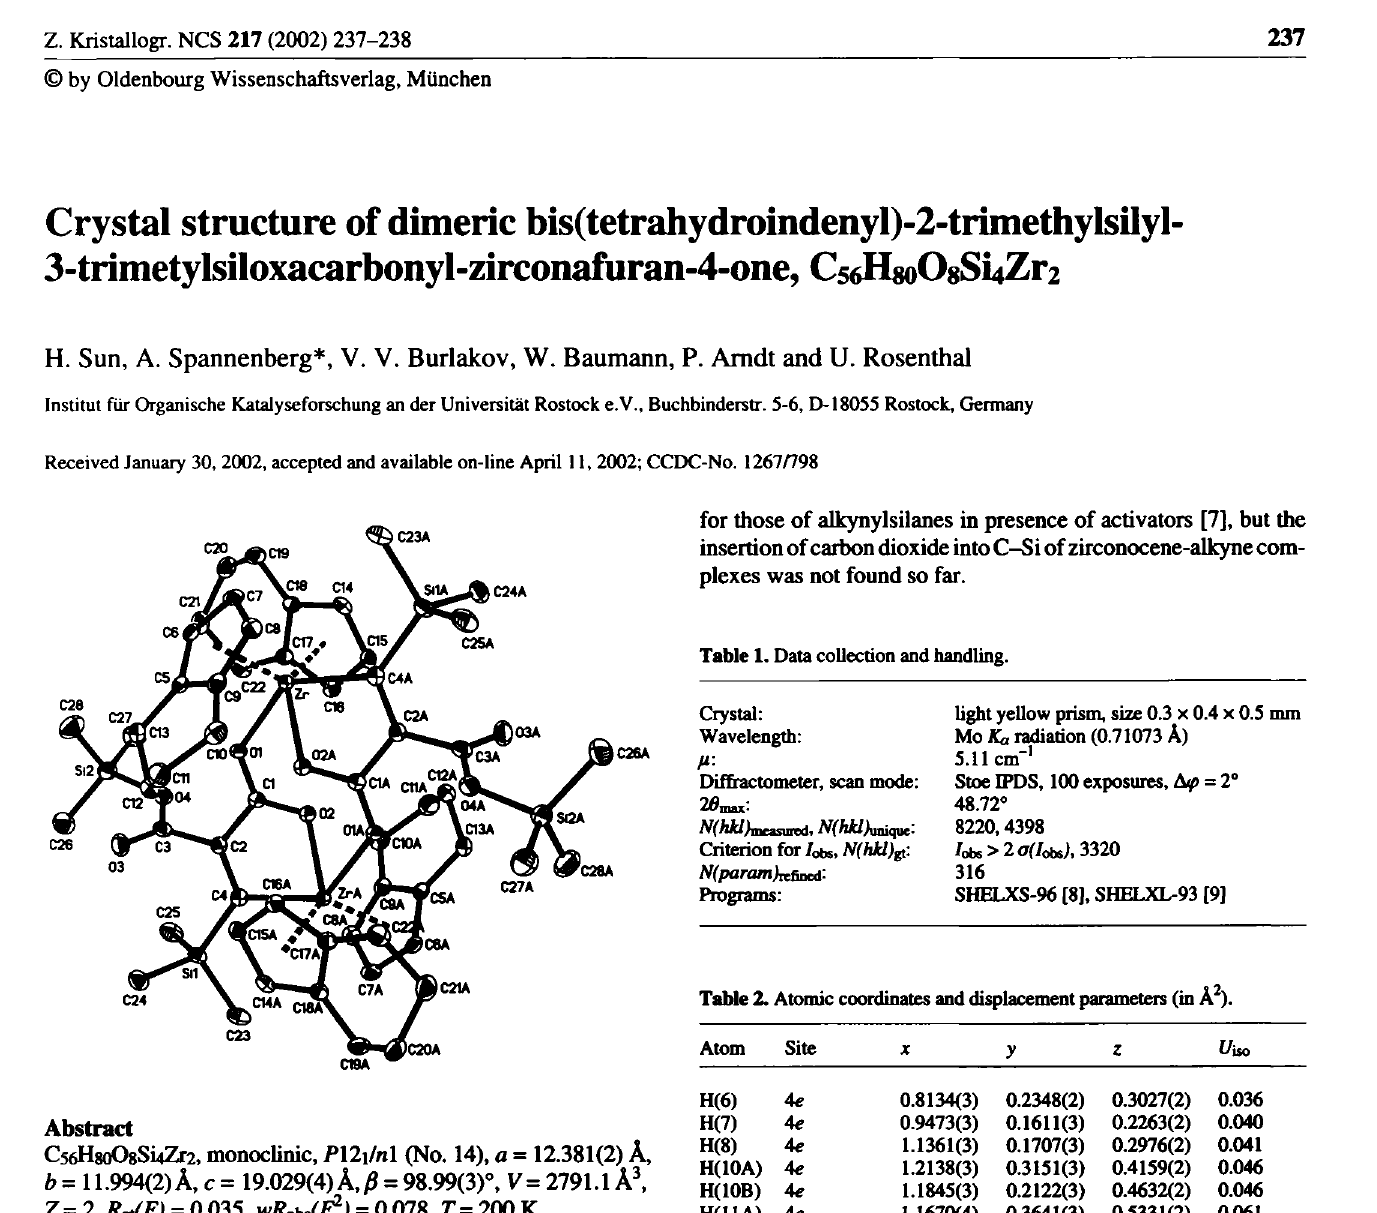
Table 2. Atomic coordinates and displacement parameters (in Â 2